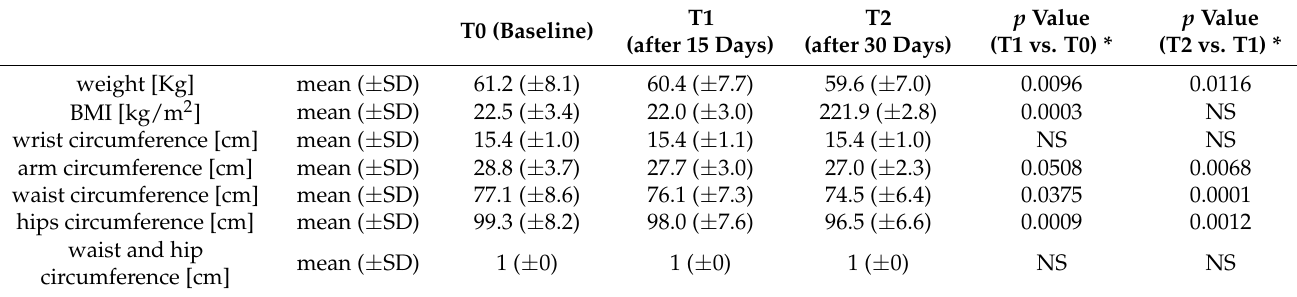
Table 4. Anthropometric findings at baseline, after 15 days and at the end of the study.